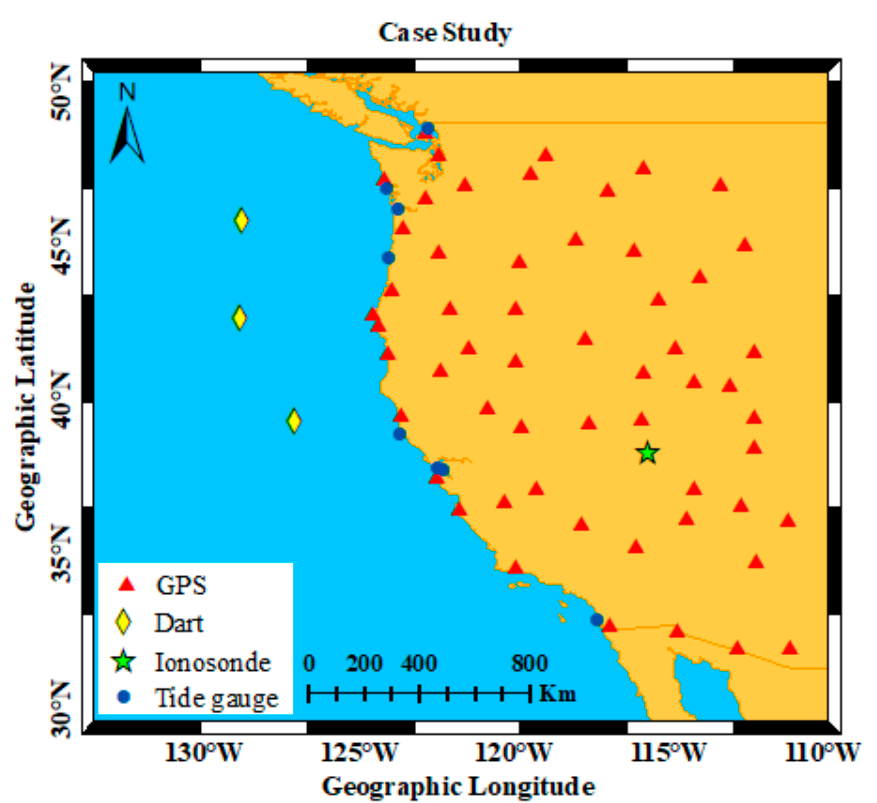
Figure 2. Case study and the spatial distribution of ground-based GPS receivers (red triangle), DART stations (yellow diamond), tide gauge stations (dark-blue circle), and ionosonde station (green asterisk) considered in this study.